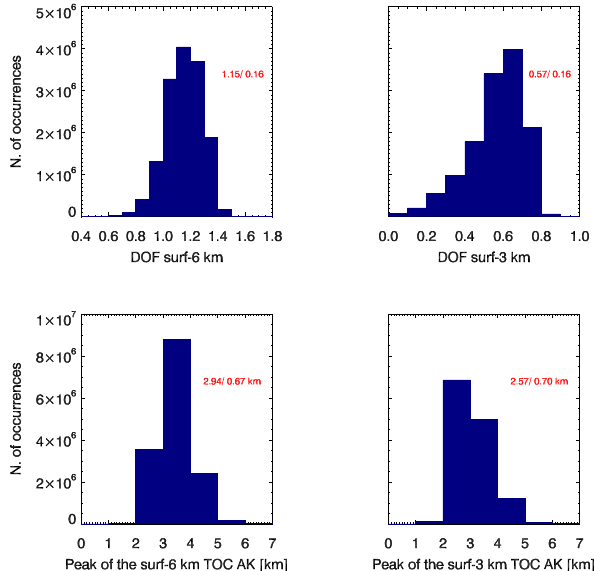
Fig. 2. Histograms of the DOF for surface–6km (top left), the DOF